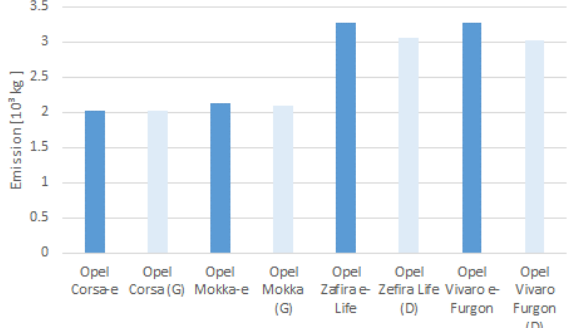
Fig. 4. Comparison of emissions of CO, NO x , PM and SO 2 for the selection of cars for testing in terms of engine displacement. G - gasoline